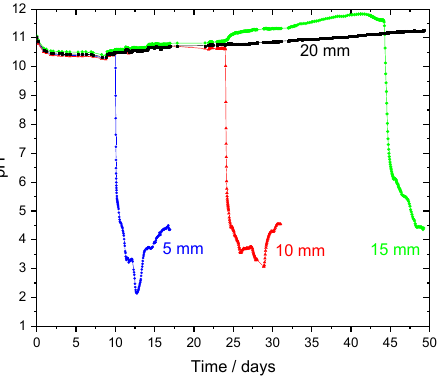
Figure 4. Mortar pH measured by the sensors at different depths: 5, 10, 15, and 20 mm.